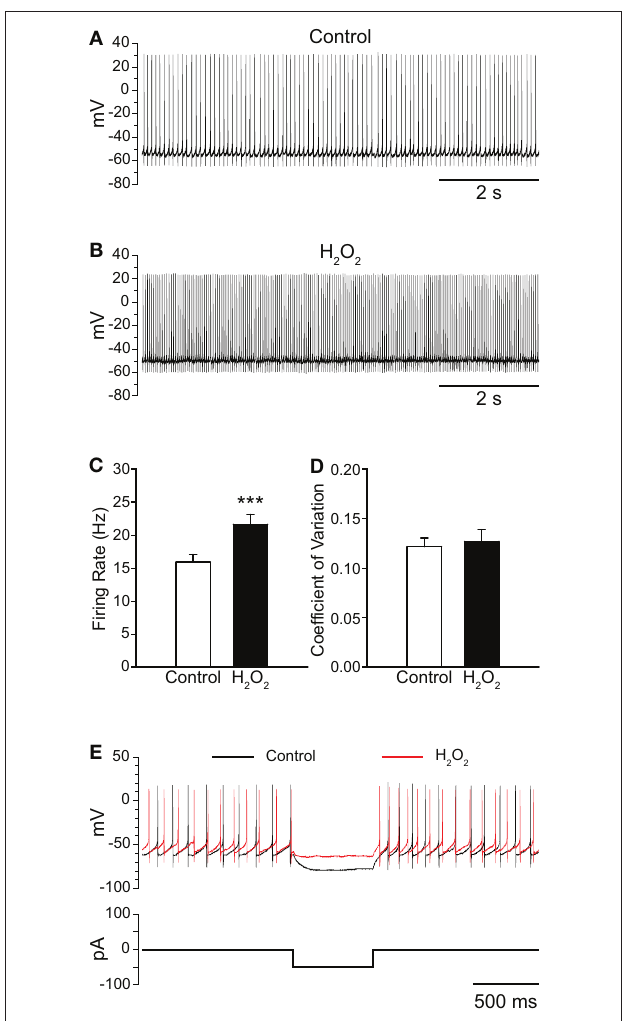
FiGuRe 1 | exogenous H O increases the firing rate of SNr GABAergic 2 2 neurons from guinea pig recorded in vitro . (A) Whole-cell current clamp recording from a SNr GABAergic neuron under control conditions and (B) following application of H O (1.5 mM). (C) H O caused an increase in firing 2 2 2 2 rate without affecting the regularity of firing as measured by the coefficient of variation in (D) . (e) The voltage deflection caused by a hyperpolarizing current pulse under control conditions (black trace) was attenuated in the presence of H O (red trace) indicating that H O decreased input resistance, consistent 2 2 2 2 with ion-channel opening. (*** p